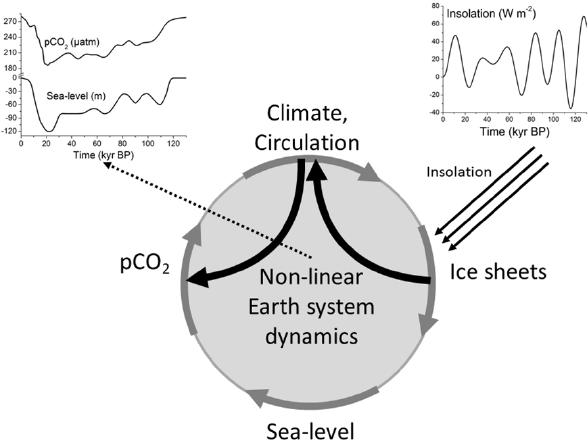
Figure 14. Key elements of the 100kyr cycle. Summer insola- tion at high northern latitudes (June insolation at 60 ◦ N, diagram in the upper right corner, Berger and Loutre, 1991) affects the growth and melting of continental ice sheets and thereby eustatic sea-level change. The glacial drawdown of atmospheric p CO 2 and its deglacial rise are supported by sea-level change. The cycle is closed by atmospheric p CO 2 affecting global climate and thereby the volume of continental ice sheets. It is accelerated and further strengthened by additional positive feedbacks: ice sheets affect the Earth’s albedo and climate while changes in ocean and atmosphere circulation support the glacial p CO 2 drawdown and are largely re- sponsible for the rapid deglacial rise in atmospheric p CO 2 . The records of atmospheric p CO 2 and eustatic sea-level change (dia- grams in the upper left corner; Monnin et al., 2001, 2004; Petit et al., 1999; Waelbroeck et al., 2002; Stanford et al., 2011) reflect the internal non-linear dynamics of the Earth system and its response to external insolation